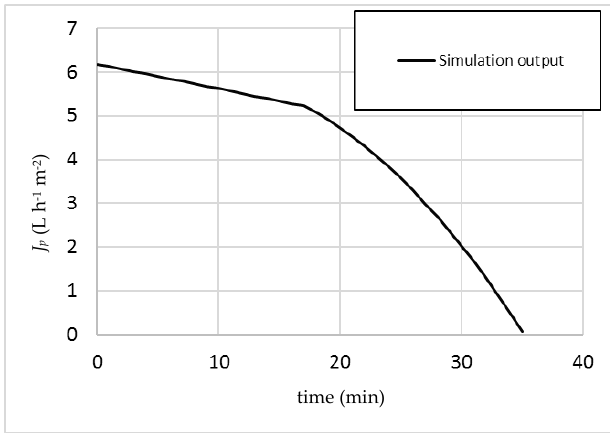
Figure 2. Simulation of the operation performed at 7 bar.